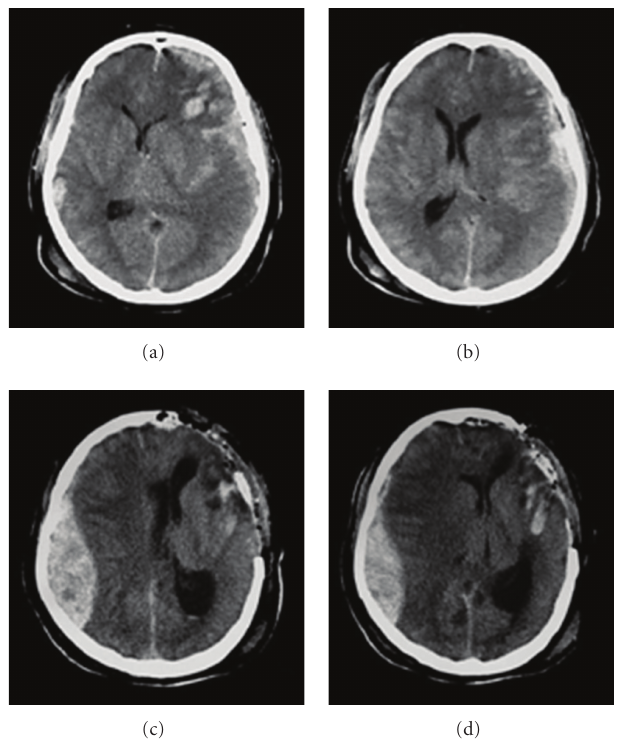
Figure 2: Case 2. Progressive epidural hematoma in a 51-year-old man after motor vehicle collisions. (a) and (b): Initial CT scans showing a left acute subdural hematoma with ventricular compression and midline shift to the right. (c) and (d): Repeat CT scans 16 hours aftertrauma and 13 hours after left frontal-temporal craniectomy; a contralateral epidural hematoma is